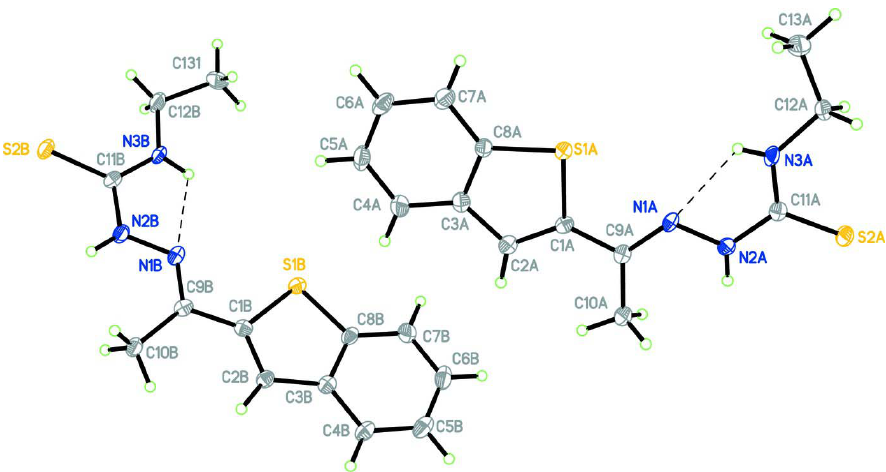
Figure 1 The asymmetric unit of the title compound, with atom labels and 50% probability displacement ellipsoids for non-H atoms. For clarity, only one disorder component is shown.